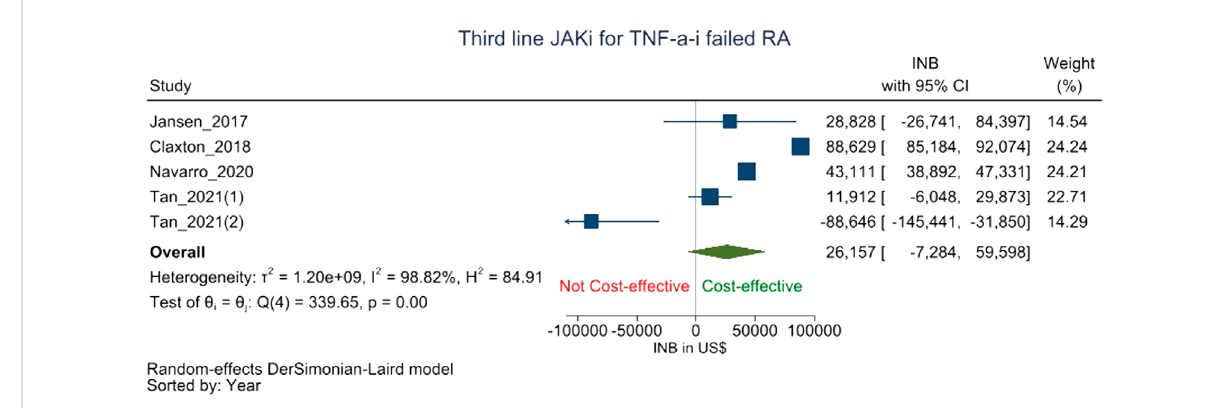
FIGURE 3 Forest plotofmetaanalysisshowingpooledINBswith 95percentCI valuesJAK-icomparedwith csDMARDs/bDMARDs forcsDMARD-TNF-a-i failed RA